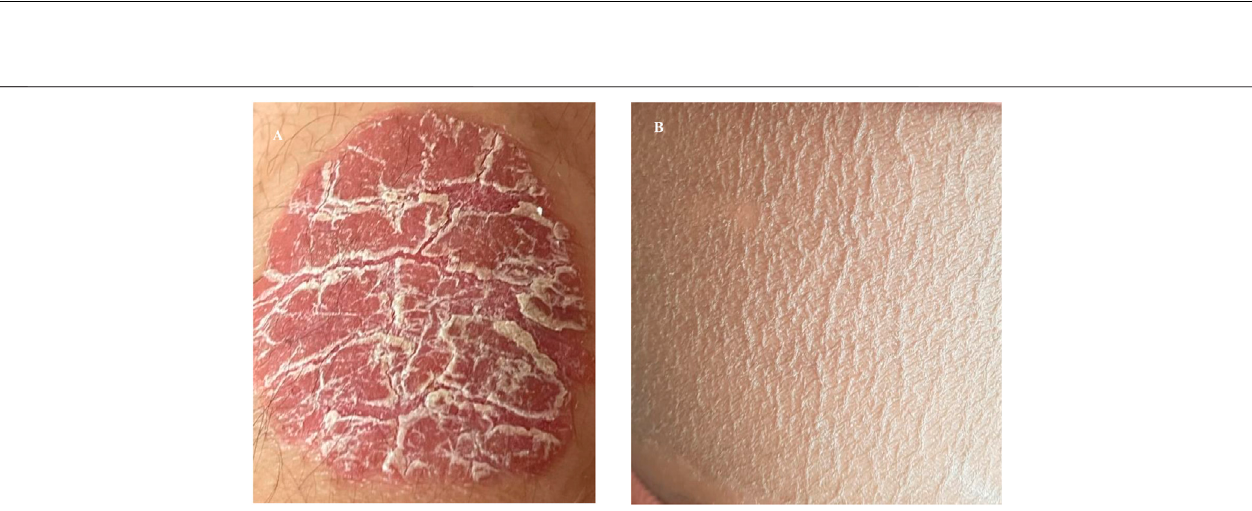
Frontiers in Genetics |